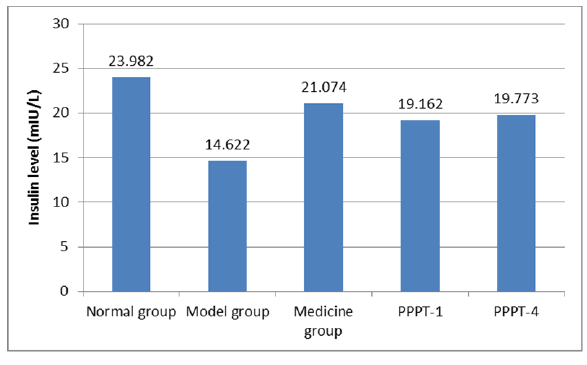
Figure 5. Effect of PPPT on insulin level in serum from type II diabetic mice.